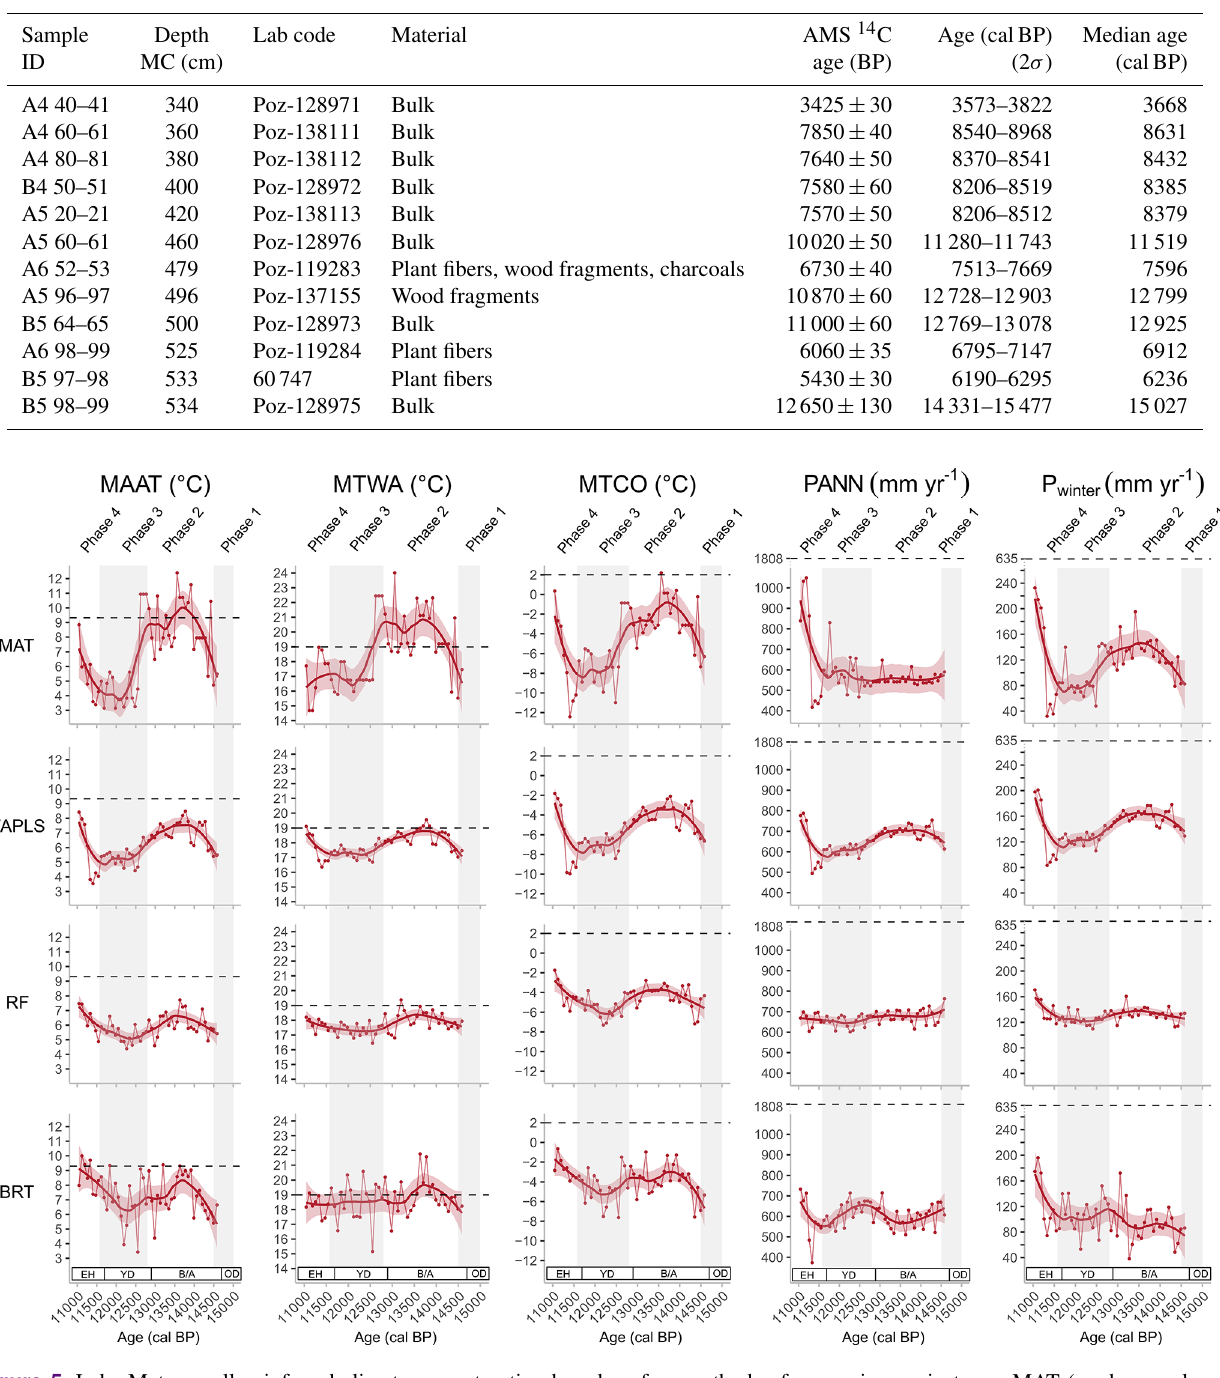
Table 3. AMS radiocarbon dates (Radiocarbon Laboratory, Pozna´n), calibrated median ages and the 2 σ range of calibration from Matese cores (MC).